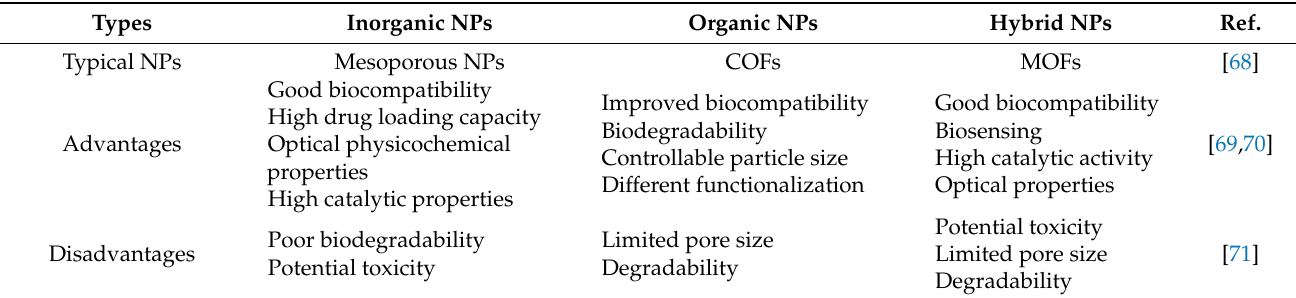
Table 2. Advantages or disadvantages of the main nanoparticle types mentioned in this